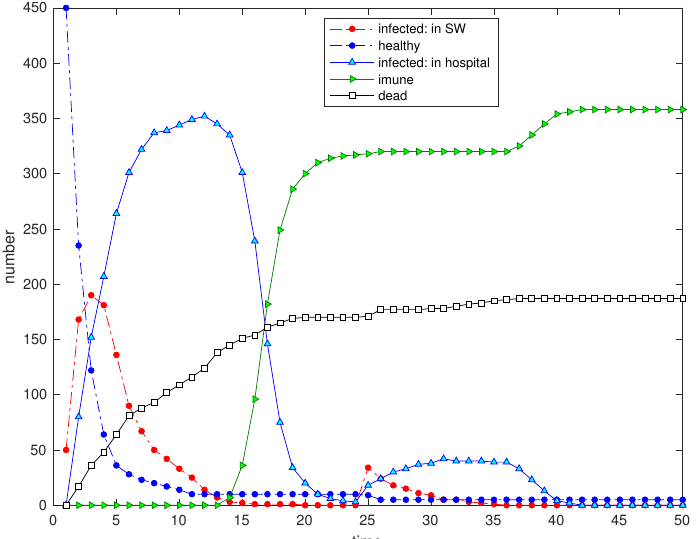
Figure 12. Scenario S 5 : Time evolution of the 5 state variables for D = 0.07 and a disturbance in the SW with the input of 50 new ‘infected’ visitors at t = 25 ( N = 500, n i = 50 at t = 1, δ = 0.1, p 1 = 0.1, p 2 = 0.9, p 3 = 0.7, p 4 = 0.05, p 5 = 0.02, α = 2 and N h → ∞